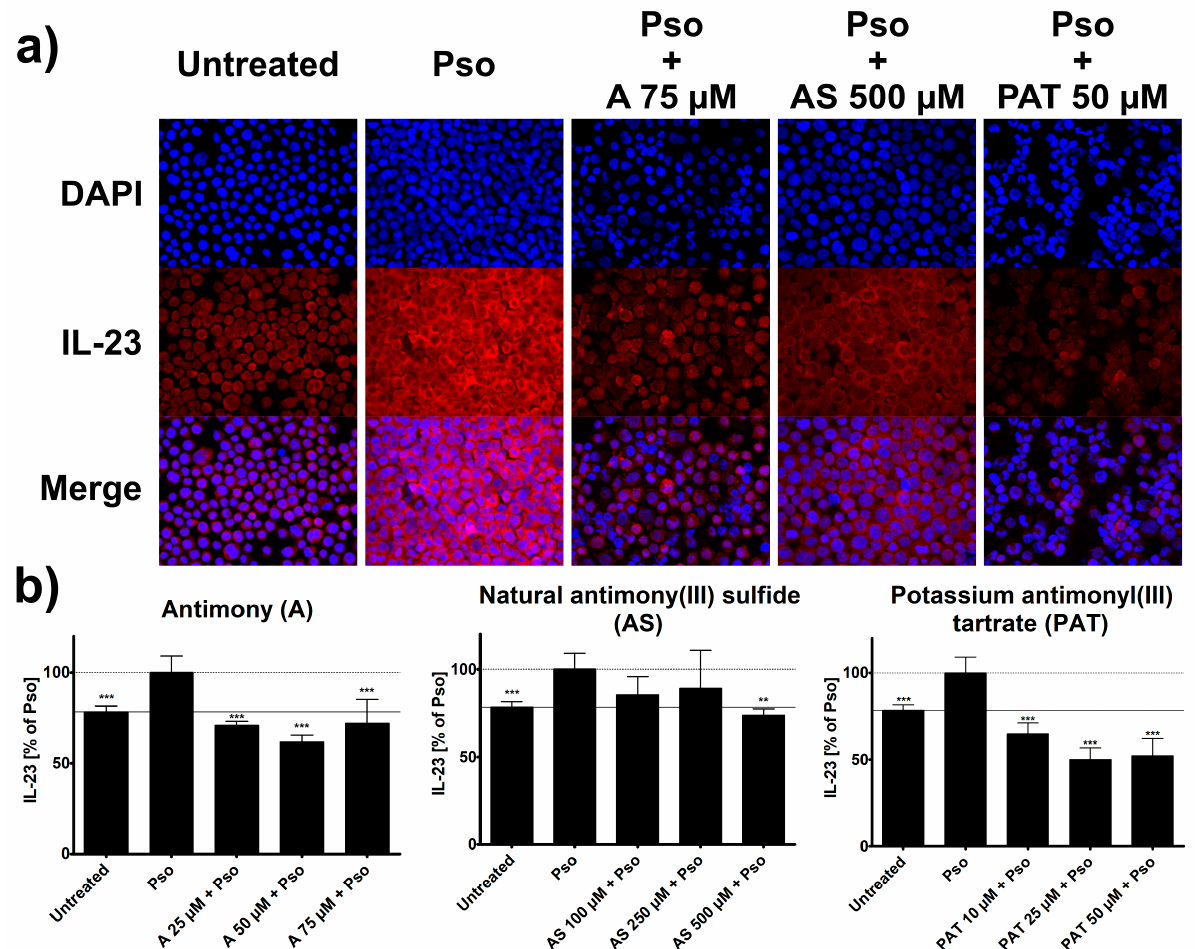
Figure 6. IFN- α -induced IL-23 expression in THP-1 cells is reduced by treatment with ACs. THP-1 cells were pretreated with A, AS or PAT for 2 h before stimulation with 10 ng/mL IFN- α for 24 h. Afterwards, cells were transferred to a glass slide using a cytocentrifuge. Cells were fixed, permeabilized and IL-23 was stained using a specific antibody. After visualization of IL-23 with secondary antibody coupled to Alexa 555 (red) and DAPI staining of the nucleus. ( a ) Representative pictures of IL-23 staining in untreated, Pso-treated and AC treated cells. ( b ) IL-23 expression was analyzed using the Intensity Ratio Nuclei Cytoplasm Tool (RRID:SCR_018573) in ImageJ. Data shown as mean ± SD of four independent experiments with two pictures per experiment. Statistical analysis was performed using column statistics with one-sample t -test comparing the samples to Pso stimulation. * p ≤ 0.05, ** p ≤ 0.01, *** p ≤ 0.001.